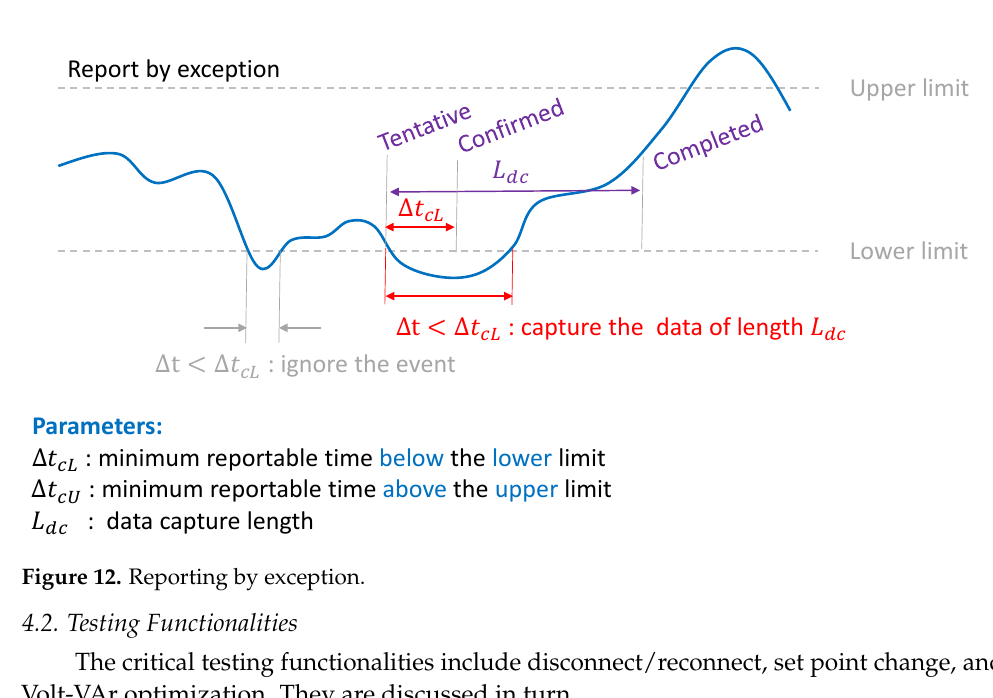
Figure 12. Reporting by exception.